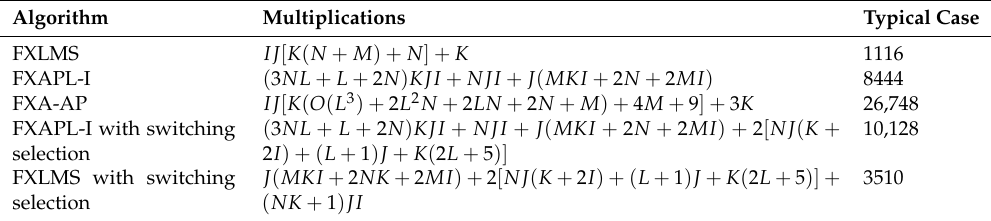
Table 5. Number of additions per iteration of the FXLMS, FXAPL-I, FXA-AP, FXAPL-I with switching selection and FXLMS with switching selection algorithms for a multichannel ANC system. Typical